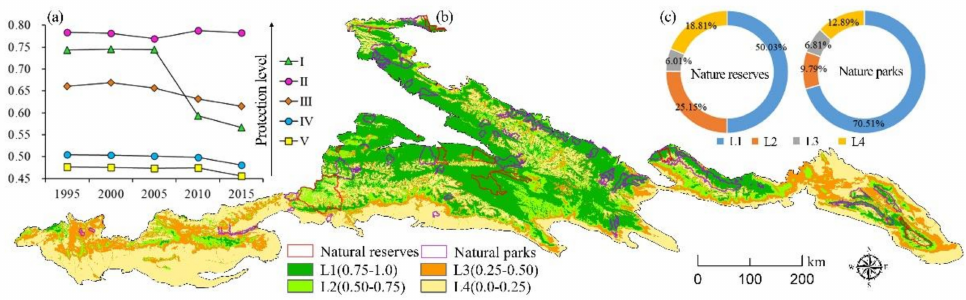
scores of habitat quality. i